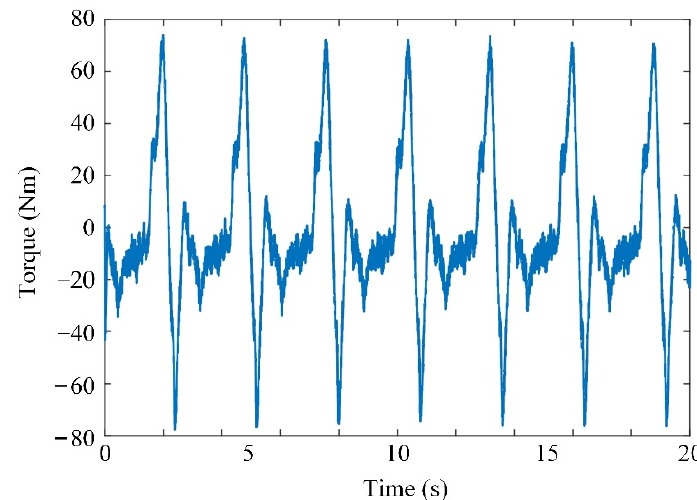
Figure 13. Generated torque.